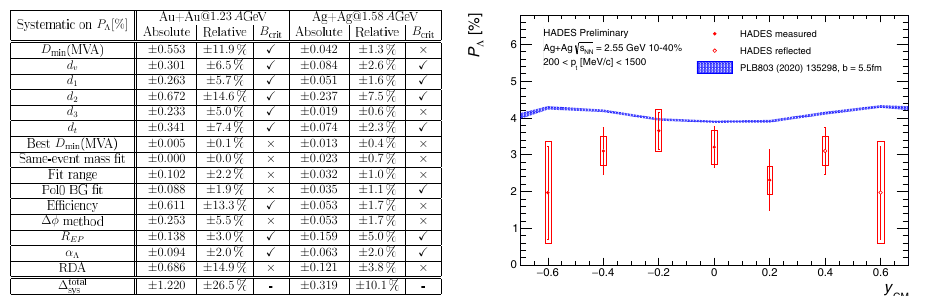
Figure 2. Left panel: Summary table of the systematic uncertainty evaluation for the integrated results in Au + Au and Ag + Ag collisions at √ s NN = 2 . 4 and 2 . 55GeV. Right panel: Global polarization mea- surement of Λ hyperons as a function of rapidity in the center-of-mass frame. The two data points at most negative rapidity have been reflected (open symbols) as the polarization is expected to be symmet- ric around midrapidity ( y CM = 0). The experimental data is compared to model calculations based on UrQMD [9] depicted by the blue